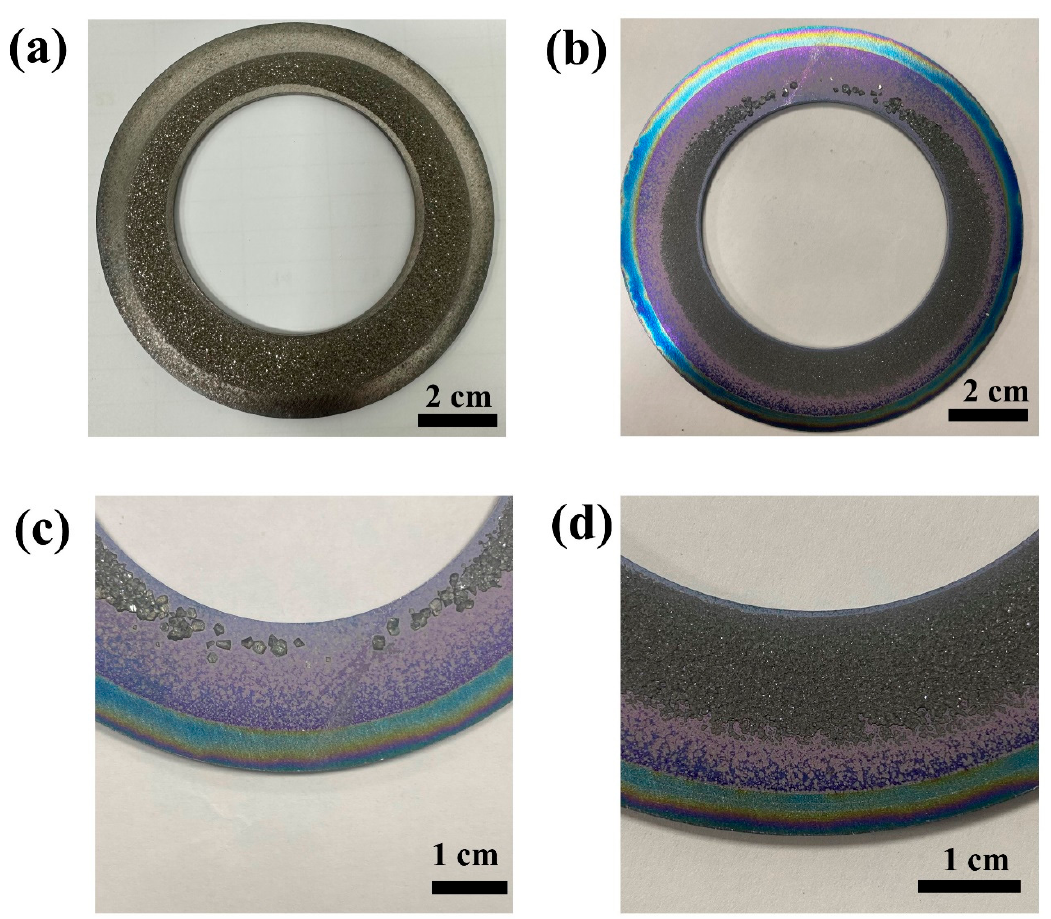
Figure 2. The photographs of the tungsten ring after growth without control ( a ) and with control ( b ), enlargement of the top ( c ) and bottom ( d ) of Figure